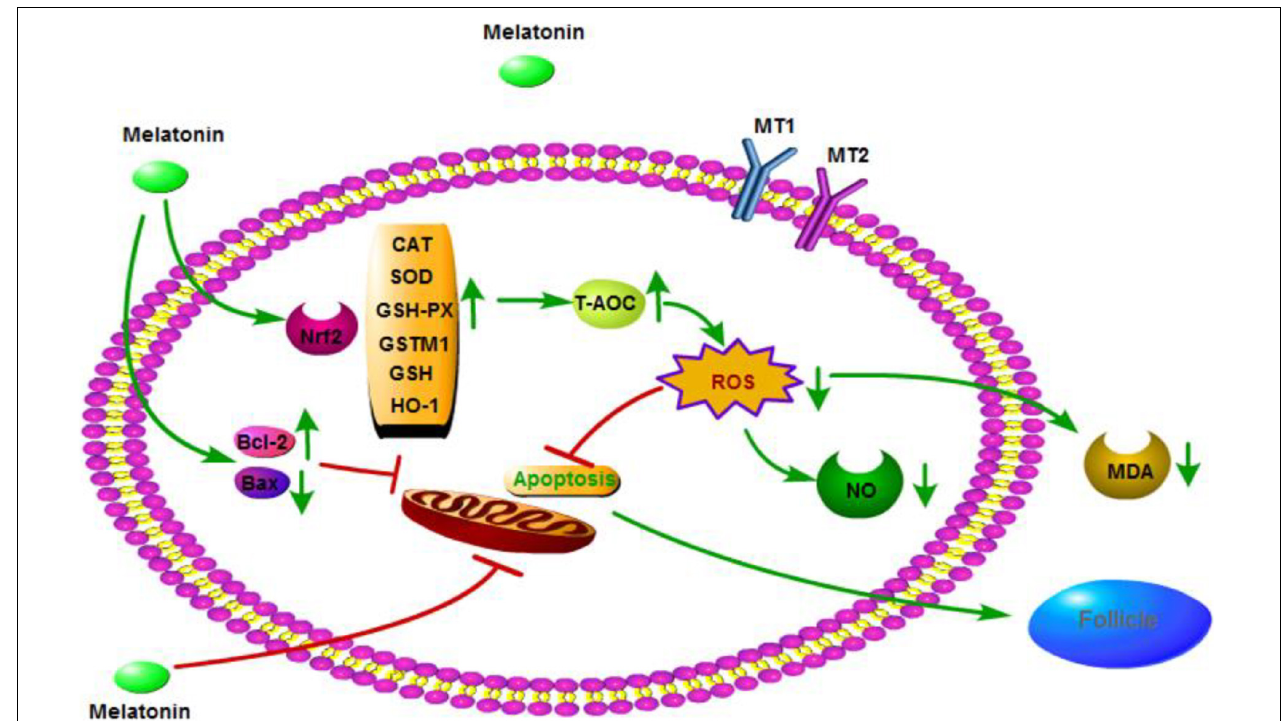
FIGURE 7 | Mechanisms by which melatonin ameliorates oxidative stress via modulation of the Nrf2 pathway in cryopreserved